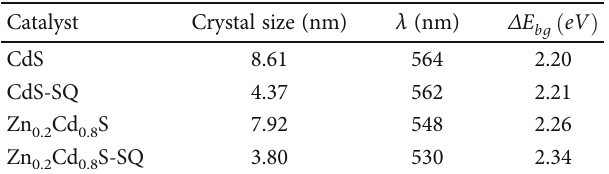
Table 1: Crystallite size (from XRD), wavelength ( λ ), and energy band gap estimation ( Δ Ebg ) of pure CdS and Zn solution obtained by coprecipitation and assisted by ultrasonic radiation.